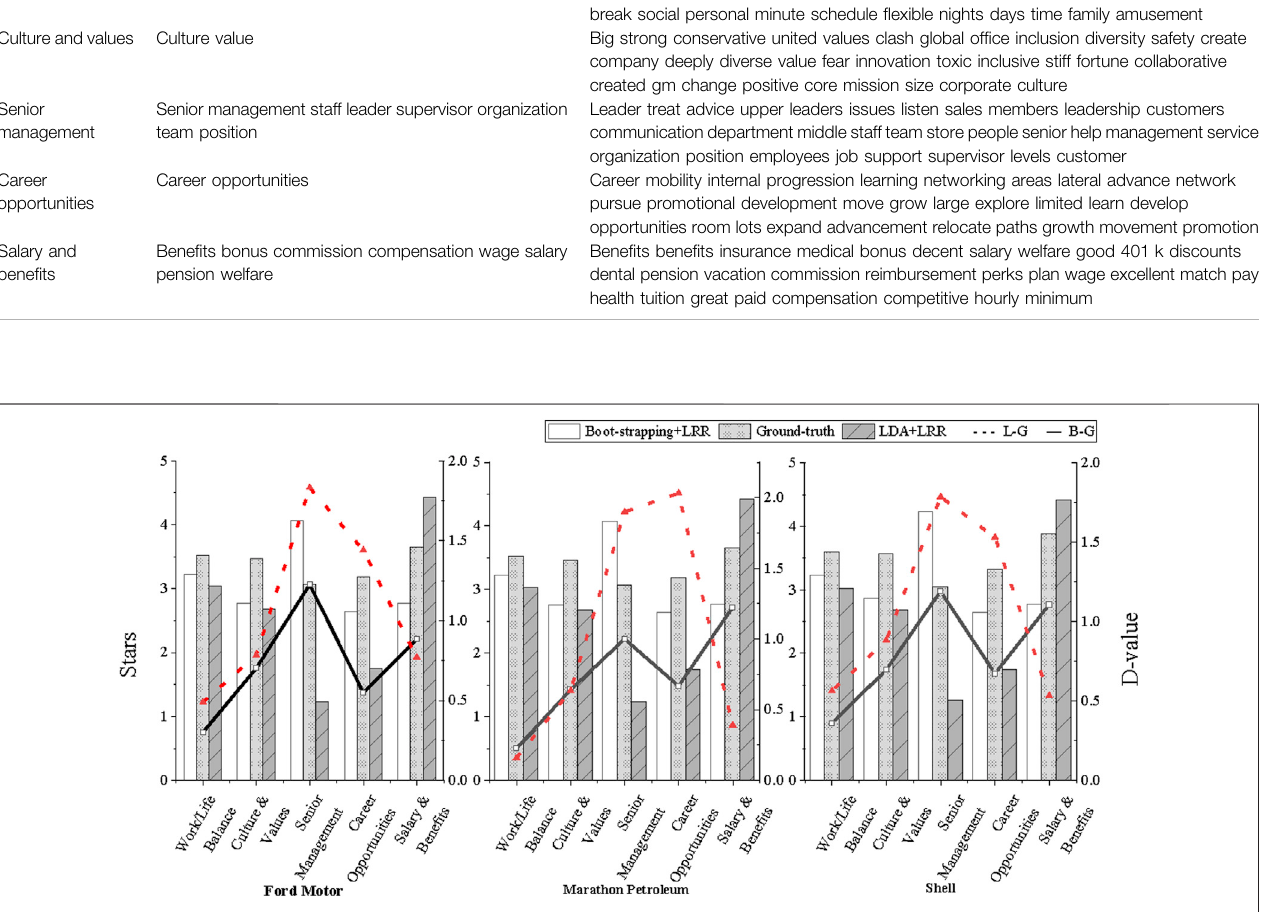
Frontiers in Physics |